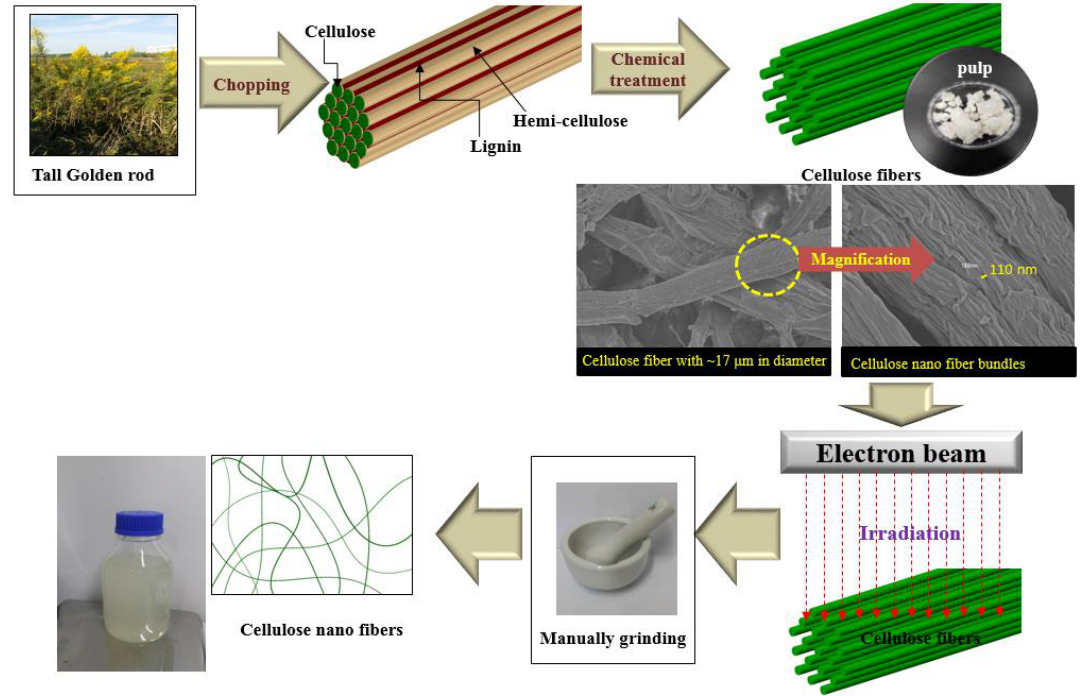
Figure 2. Schematic diagram of the preparation of cellulose nanofibers from tall goldenrod.